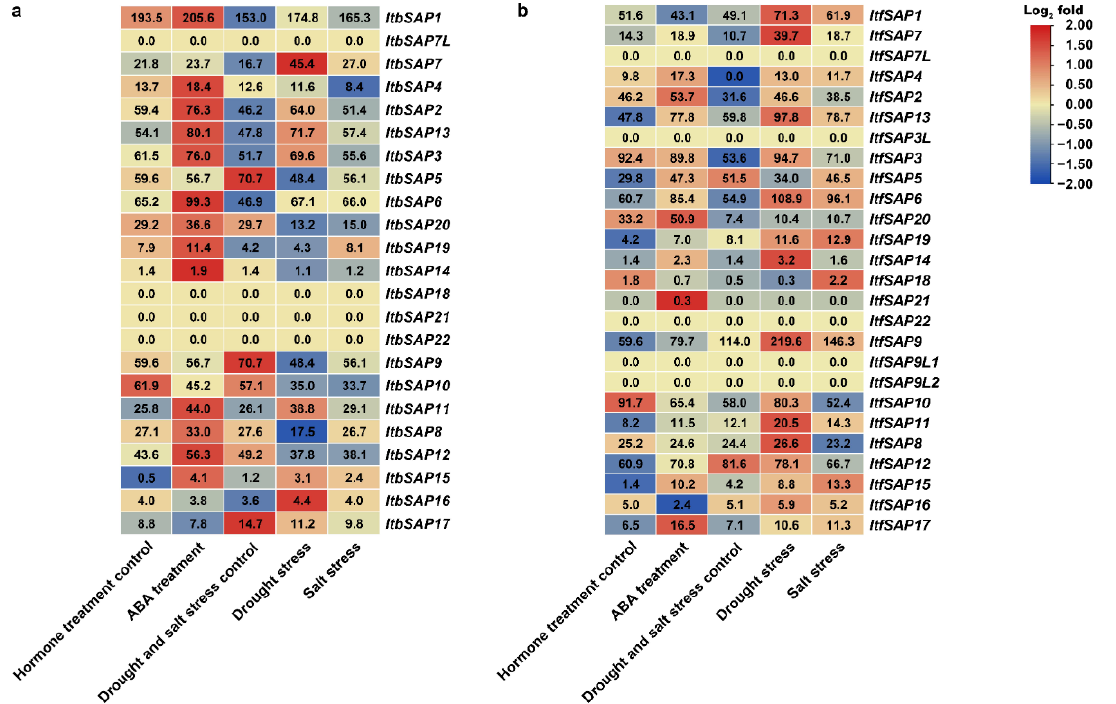
Figure 7. Gene expression patterns of ItbSAP s ( a ) and ItfSAP s ( b ) in response to ABA treatment, drought stress, or salinity stress as determined by RNA-seq. FPKM data are shown in the boxes. 2.7. Ectopic Expression of IbSAP16 Enhanced Salinity Tolerance of Transgenic Arabidopsis Plants